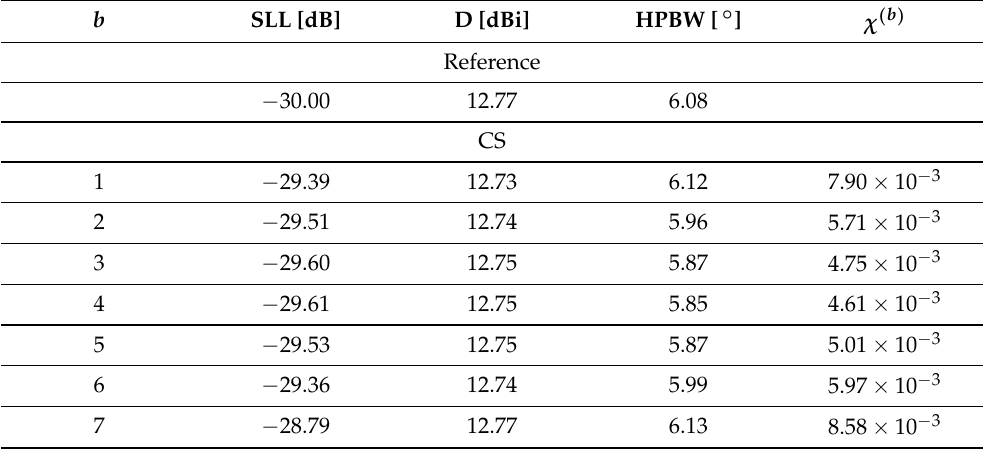
Table 2. Numerical Assessment ( I = 22, M = 16, d = λ matching